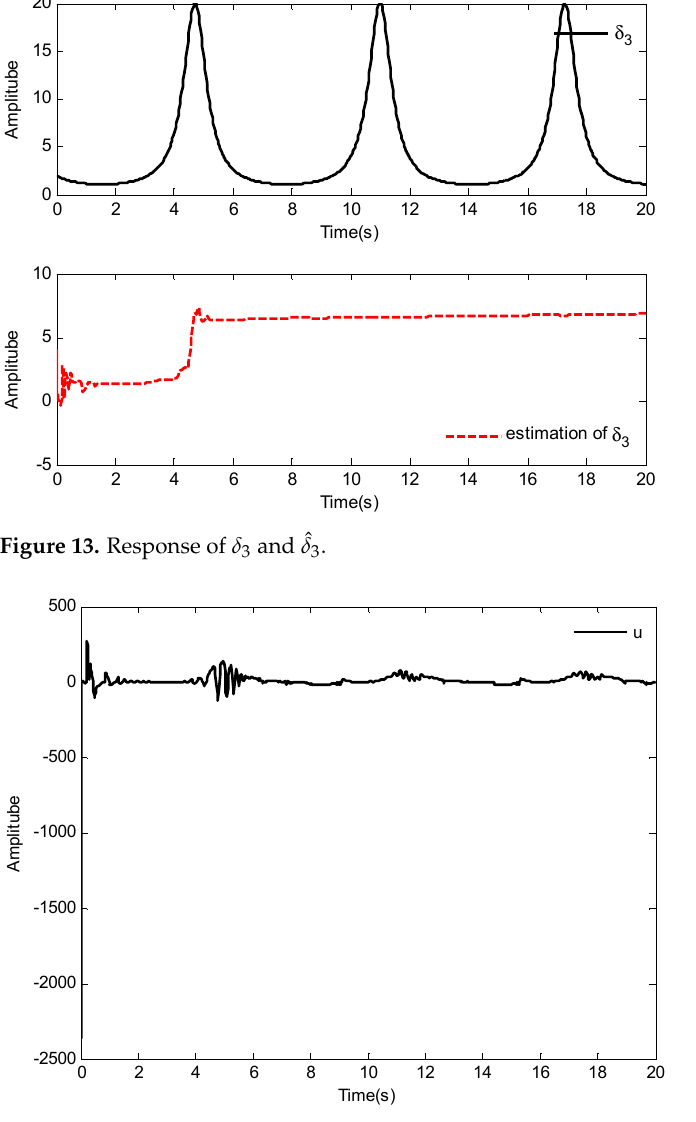
Figure 12. Response of